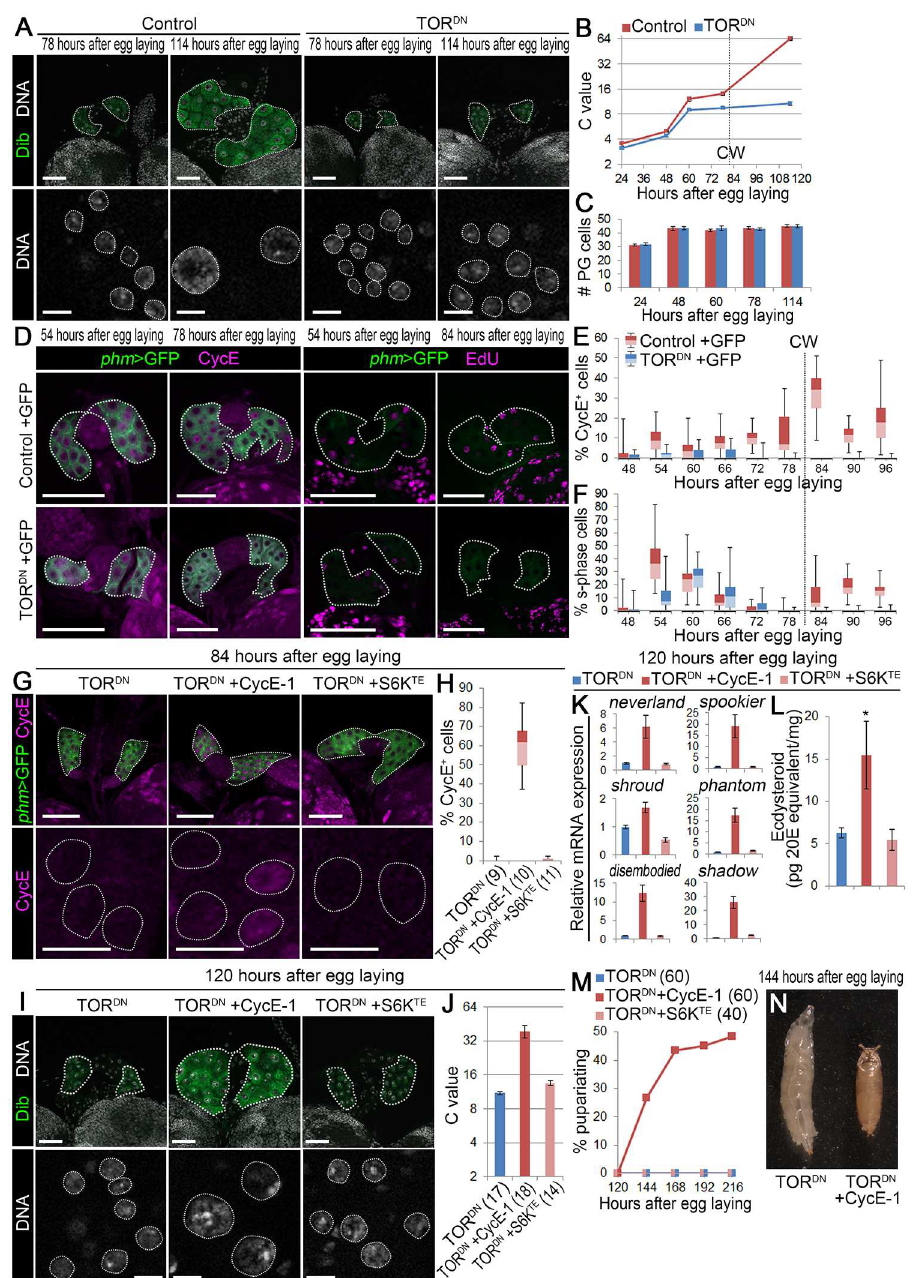
Fig 4. TOR is required for endocycle progression to activateecdysone biosynthesis. (A) Expressionof TOR DN in the PG causes arrest in DNA content increaseat the 3rd instar larvalstage. The PGs (upper panels, outlined)and nucleiof PG cells (lower panels,outlined)of control ( phm22 > + ) and TOR DN ( phm22 > TOR . TED ) animalswere labeledfor Dib (green) and DNA (white) at 78 and 114 hAEL. Scale bars, 50 μ m (upper panels) and 10 μ m (lower panels). (B and C) The C value (B) and number (C) of PG cells of control and TOR DN larvae at indicatedstages. The CW checkpointin control (81 hAEL, see S4O Fig) is indicatedby a dashedline in B. 11–19 PGs were analyzedfor each group. Average C value in control at 114 hAEL is normalized to 64C. Error bars represent standard errors. (D) Expressionof TOR DN in the PG causes reduction in CycE expressionand EdU incorporation at the 3rd instar larval stage. The PGs of control +GFP ( phm22 > mCD8 :: GFP ) and TOR DN +GFP ( phm22 > mCD8 :: GFP , TOR . TED ) larvaewere labeledfor GFP (green)and CycE or EdU (magenta) at indicatedstages. The PGs are outlinedby dashed lines. Scale bars, 50 μ m. (E and F) Percentages of CycE-positive (E) and EdU-positive (F) PG cells in control +GFP